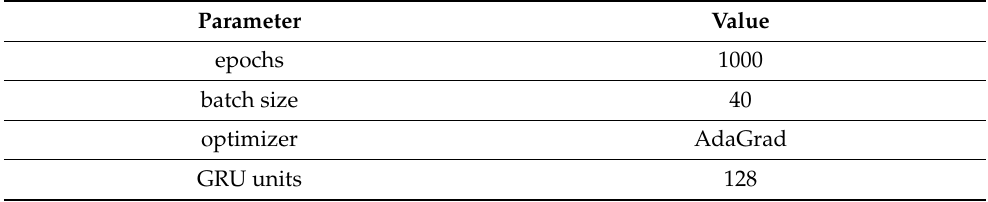
Table 4. Description of